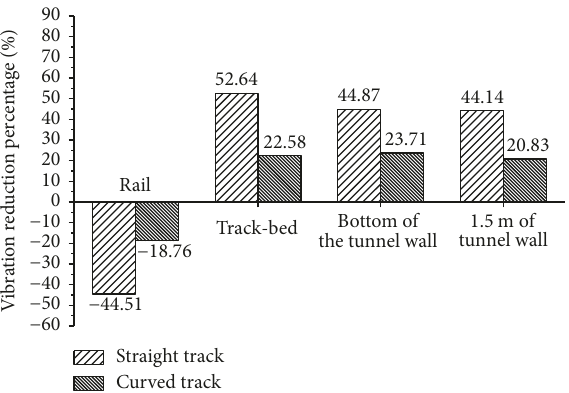
Figure 17: Comparison of acceleration